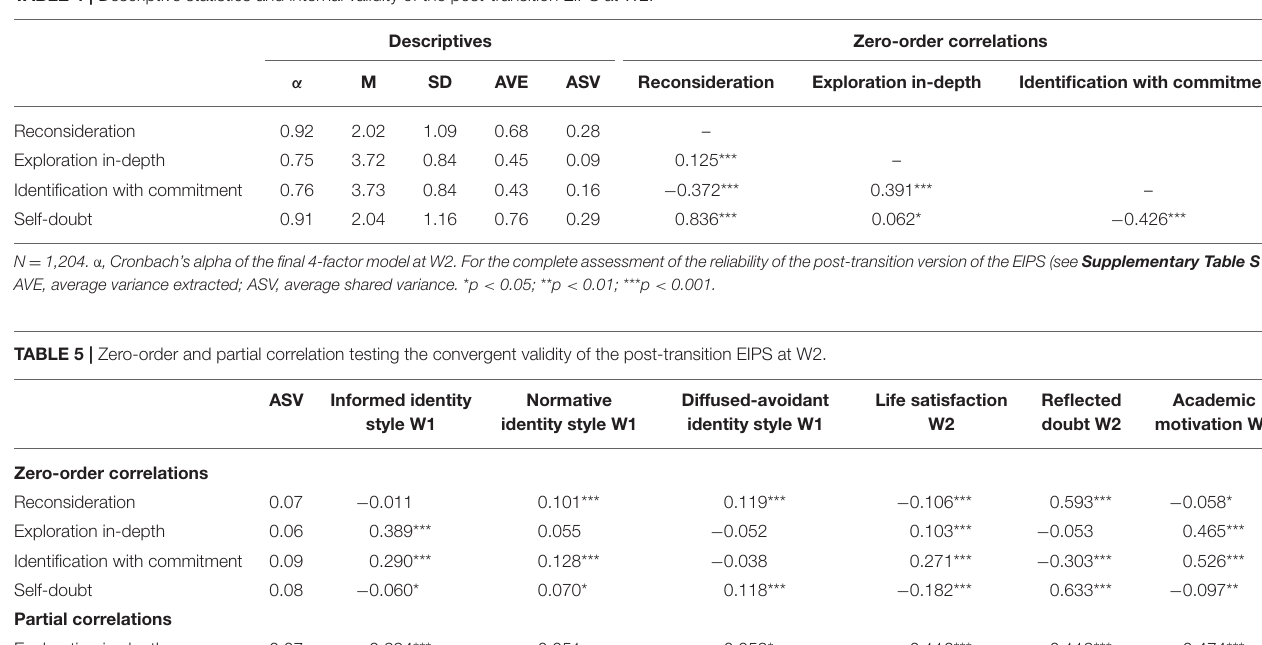
TABLE 4 | Descriptive statistics and internal validity of the post-transition EIPS at W2.